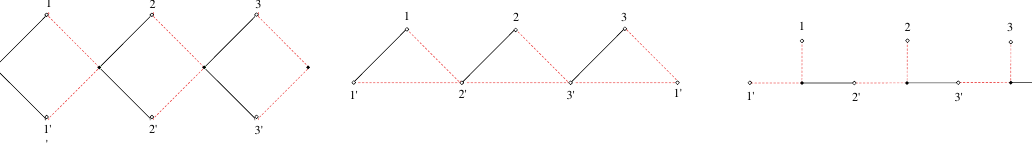
Figure 19 . Left: spinning inhomogeneous fishnet Feynman diagram: any red line and green line carries a different Weyl spinor representation (∆ to the auxiliary space representations and their representation is set to (∆ Each integration point on the left is identified with the corresponding on the right, so the graph is wrapped on a cylinder. Right: quartic vertex of the planar lattice.